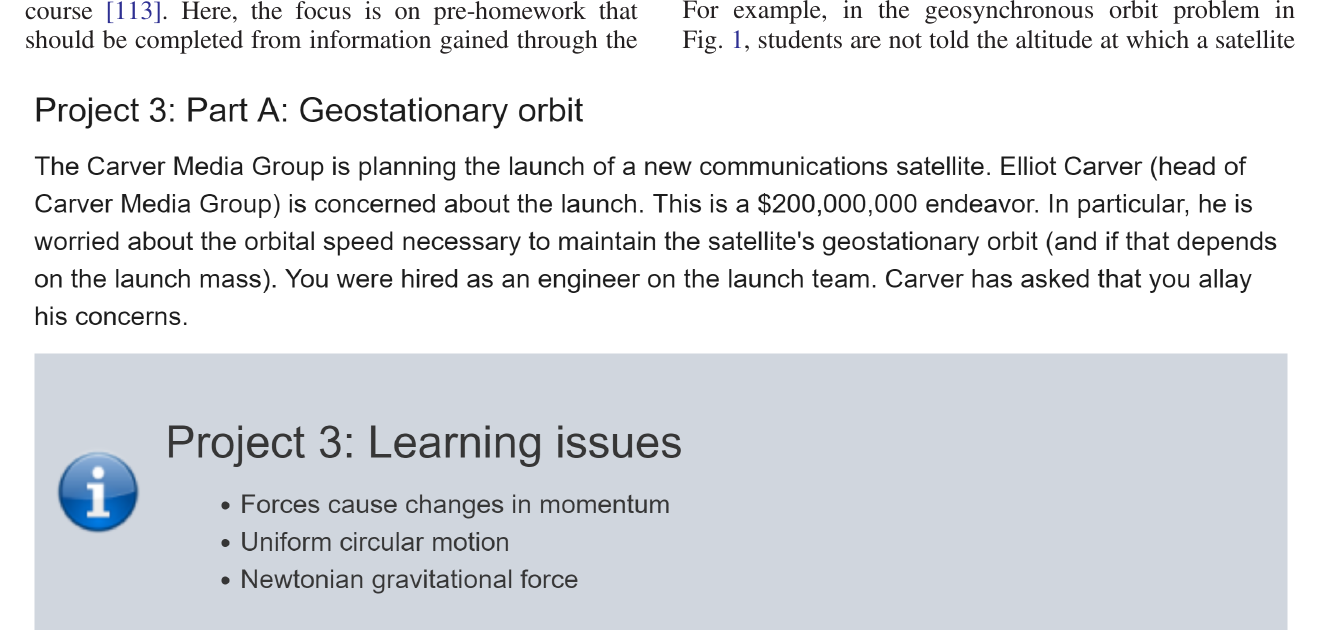
FIG. 1. This is the activity prompt for one of the authentic activities used in the P-Cubed classroom. This activity is expected to take a group of four students two hours to